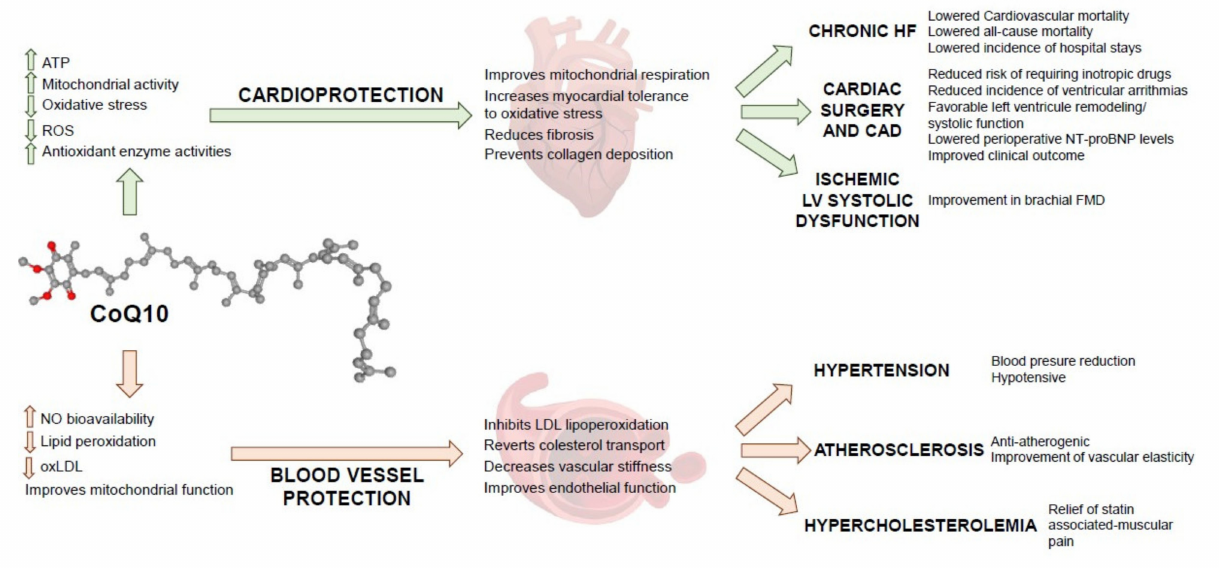
Figure 1. Mechanisms of action of CoQ10 in cardiovascular disease. ATP: adenosine triphosphate; ROS: reactive oxygen species; NO: nitric oxide; LDL: low-density lipoprotein; NT-proBNP: N-terminal prohormone BNP; FMD: flow-mediated dilation; CAD: coronary artery